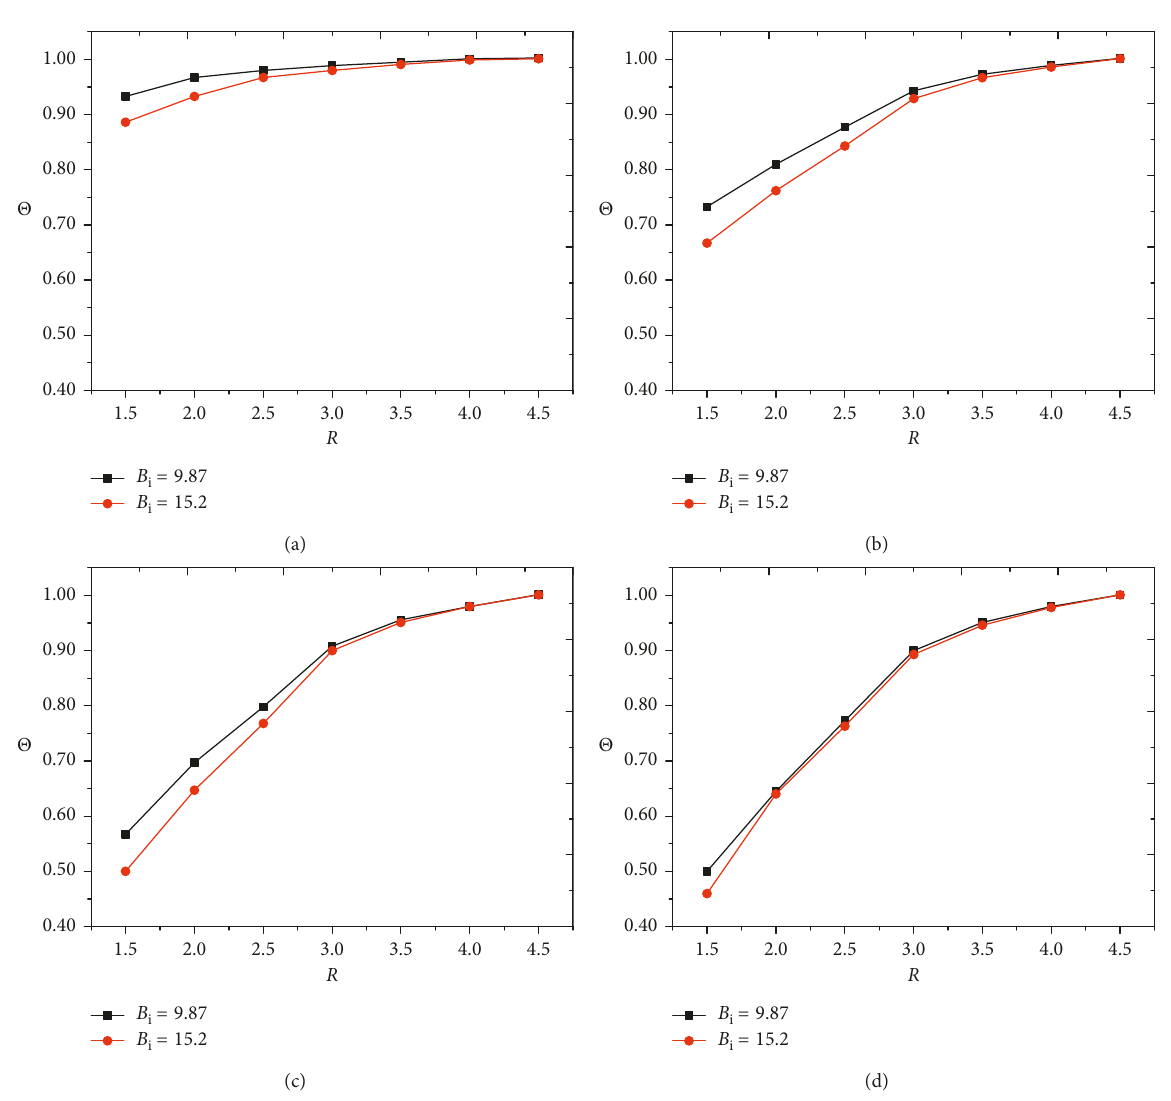
0.067. (b) F o (cid:31)